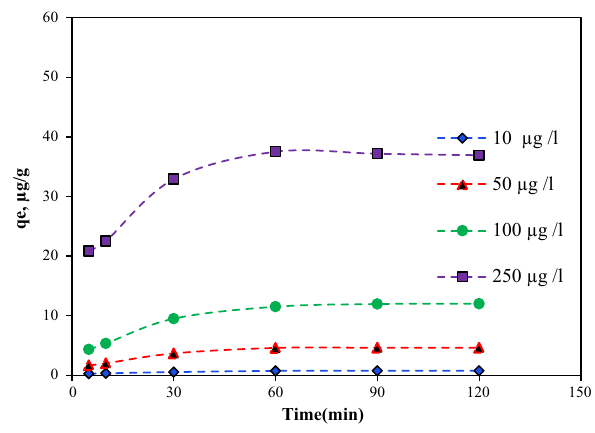
Fig. 4 Effect of temperature and initial concentration on arsenic removal by modified saxaul ash (optimum adsorbent dosage of 1.5 g/L, optimum pH of 7 and optimum contact time of 60